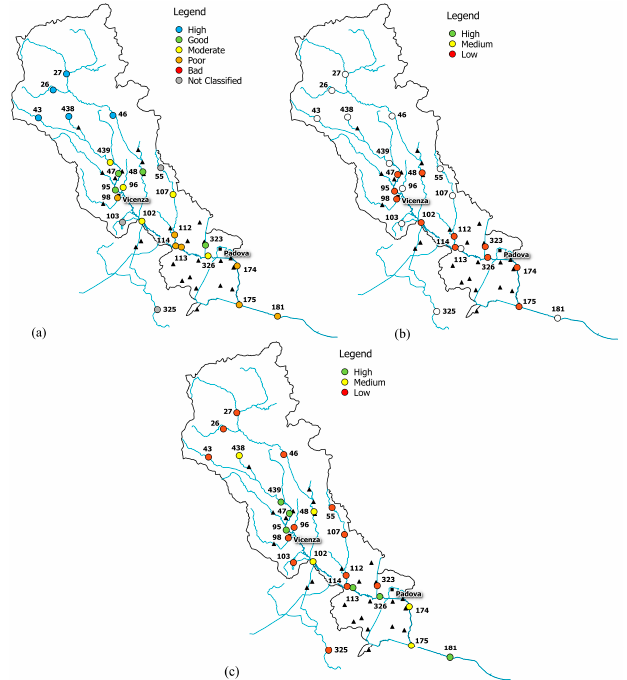
Figure 8. ( a ) Water-quality classification according to the macro-descriptor LIMeco; ( b ) level of functional integrity for the Non-Treated Loads index; ( c ) level of functional integrity for the Total Pollutant Reduction index (year 2015).